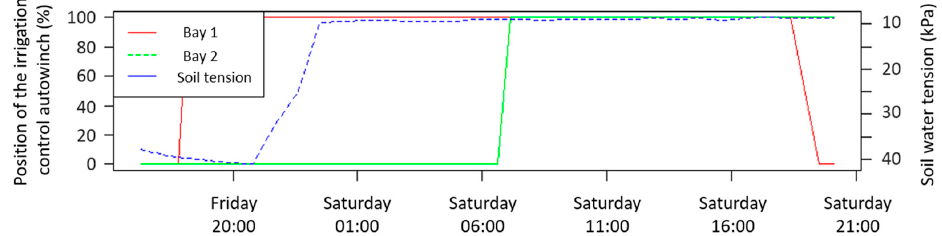
Figure 12. Position of the irrigation control autowinches (100% = fully open; 0% = closed) in bays 1 and 2.